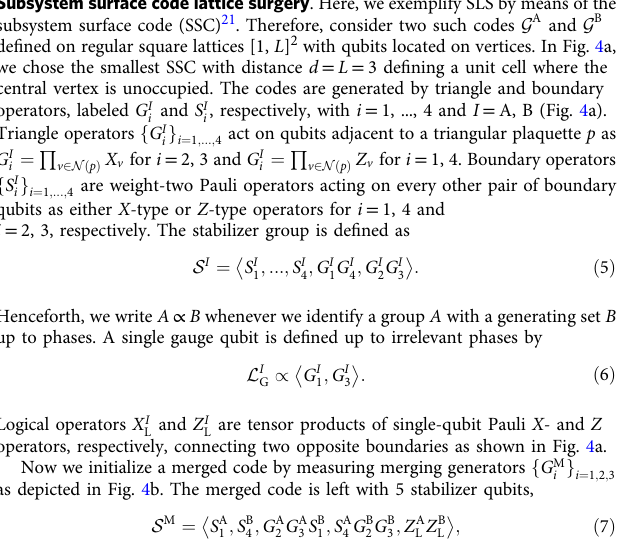
Fig. 4 Subsystem lattice surgery between two subsystem surface codes. a Example of two subsystem surface codes with distance 3 labeled by A, B, respectively. Qubits are located on vertices depicted in blue, while the central gray vertices are unoccupied. Plaquette generators G I i and S I i ( I = A, B) are color coded with X -type and Z -type operators drawn in yellow and orange, respectively. Representative logical Pauli operators X I depicted by dashed lines and are tensor products of single-qubit X and Z operators, respectively. b The merged code, labeled by M, with additional merging generators G M i colored in fuchsia. Some X -type operators in S M and L M are merged across the boundary in accordance with Eqs. (7) and G (8). Including merging generators to the codes reduces the dimension of the logical subspace by